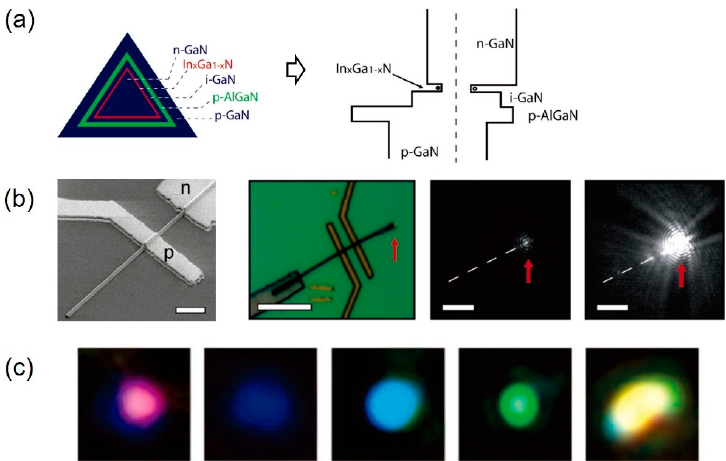
Figure 8. Core/multishell single GaN NW heterostructure LEDs. ( a ) Schematic of the NW cross section displaying coaxial heterostructure with core-to-shell n - i - p doping profile (left). Energy band diagram of the NW (right). ( b ) SEM and bright-field optical microscope images of the fabricated single GaN NW LED (left). Electroluminescence images of the device with different forward bias voltages of 9 V and 11 V, respectively (right). Red arrows and white-dotted lines indicate the NW end and body, respectively. ( c ) Multicolor emissions of NW LEDs: purple, blue, greenish-blue, green, and yellow (left to right) [37]. Figure reproduced with permission from American Chemical Society.